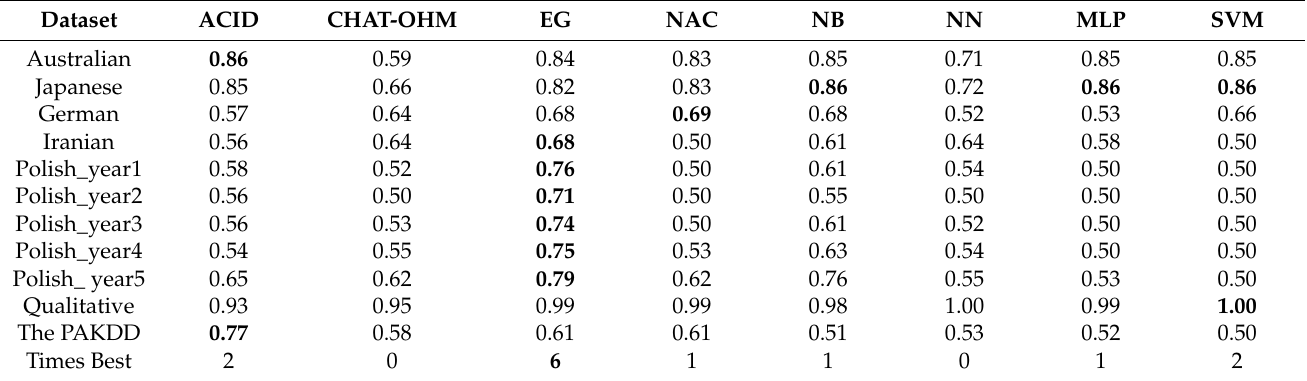
Table 9. Area under the ROC curve for associative-based and other supervised